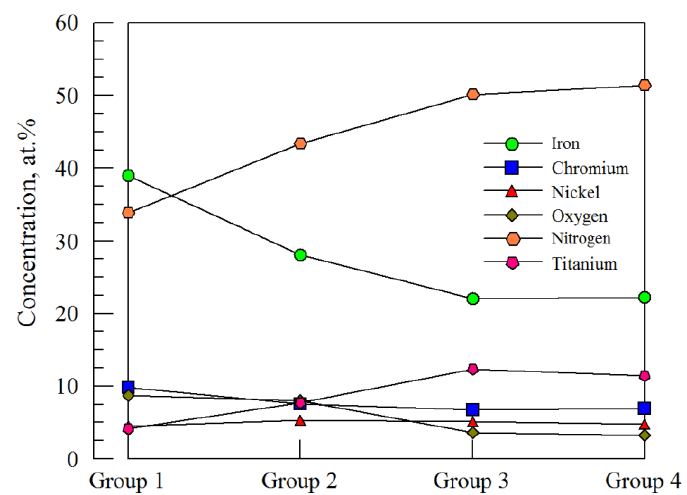
Figure 1. Average compositions of the deposited films within each group based on the results shown in Table 1. The increase in Ti correlates with the increase in nitrogen, which is due to the strong gettering effect of Ti for N.